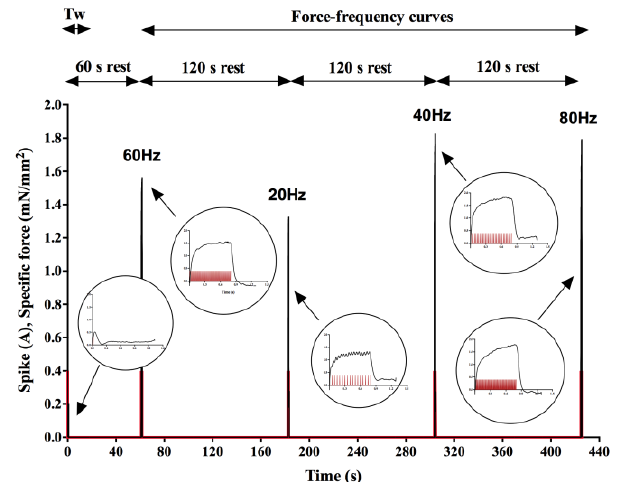
Figure 4. Example of an entire stimulation protocol for the measurement of the contractility of a control X-MET on day 0 of acquisition. Specific force (black) developed by the tissue when subjected to one twitch test and four tetanic stimulations (current spikes are in red).